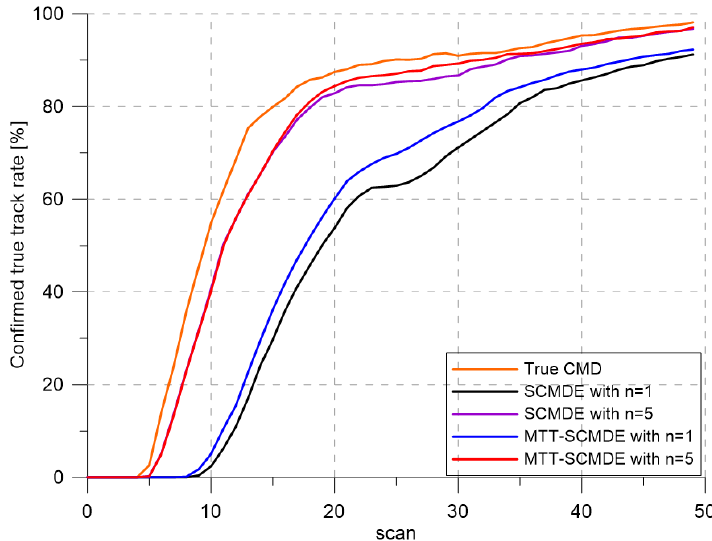
Figure 4. Confirmed true track rate. CMD, clutter measurement density.